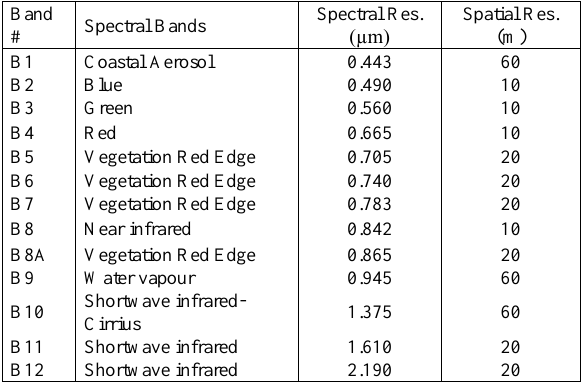
Table 1 . The characteristics of Sentinel-2 data.